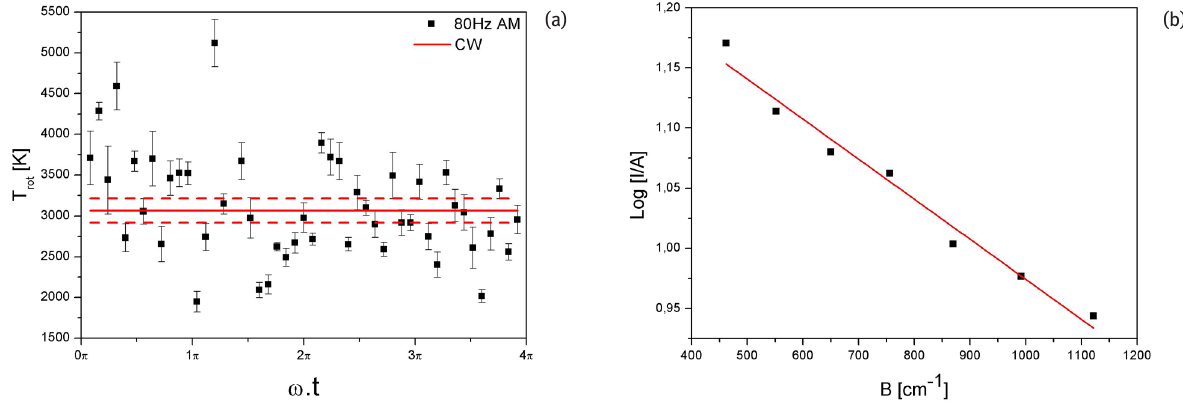
Figure 7 : On the left, there is time-resolved rotational temperature 2 mm outside the discharge tube calculated from 1 st negative system of nitrogen for 80 Hz AM. The results for CW excitation are shown, too. On the right, there is a typical Boltzmann plot used for a calculation of the temperature (ω t =